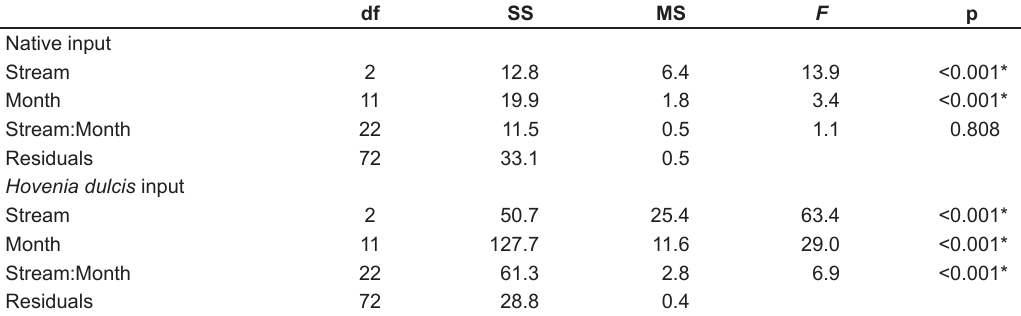
Table 1. Result of Analysis of Variance (two-way ANOVA) on organic matter input of native species and H. dulcis among streams and months. Degrees of freedom (df), sum of squares (SS), mean of squares (MS), test value (F) and test significance (p) are described.